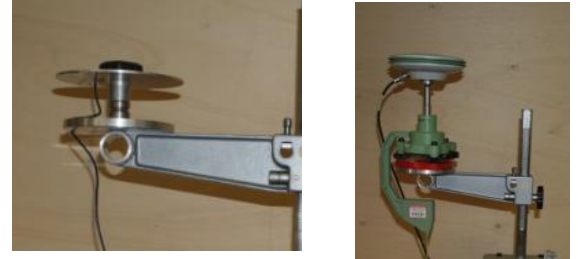
Figure 13. Antenna support: patch (left) and geodetic (right) The bar was mounted in a known direction which was defined with two known points that were determined with a static positioning GPS. Several scenarios, in terms of instruments, were considered: geodetic receiver and geodetic antenna; mass market receiver (L1 - u-blox 5T) and geodetic antenna (Figure 13 right); mass market receiver (L1 - u-blox 5T) and patch antenna (Figure 13 left).